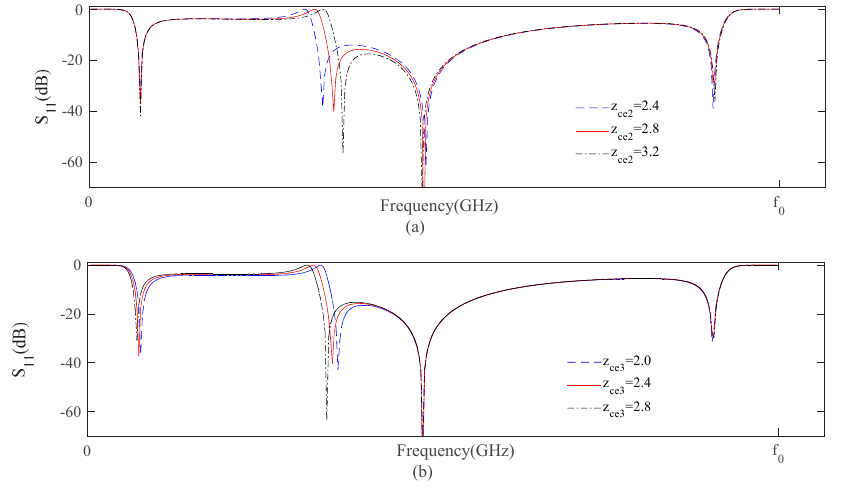
Figure 5. Simulated frequency responses of the proposed CLCSR filter with varied parameters ( a ) z ce 2 and ( b ) z ce 3 .